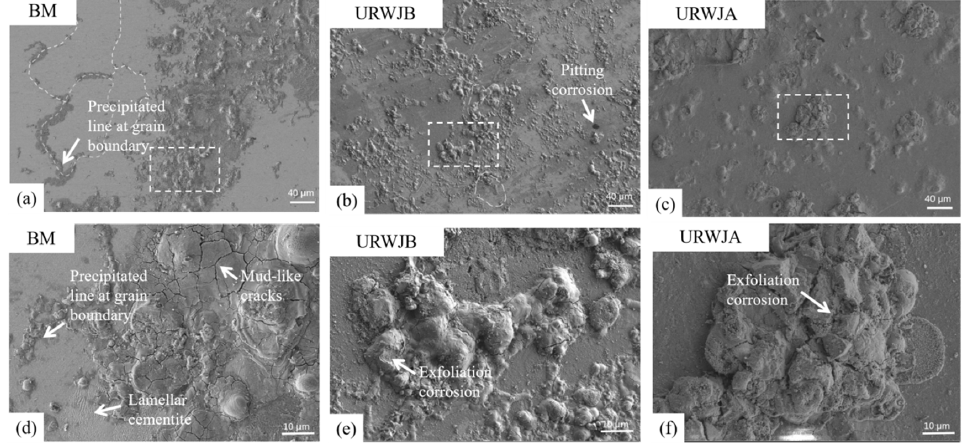
Figure 9. Morphology of samples after electrochemical test: BM, URWJB, URWJB. Without normalisation, all the microzone surfaces of the URWJs were severely cor ‐ roded after cyclic potentiodynamic polarisation, showing major non ‐ uniform surface ex ‐ foliation and a large number of dispersive corrosion products (Figure 9b,e). After normal ‐ isation, the corrosion products were more densely distributed on the sample surface com ‐ pared to the URWJB samples (Figure 9c,f). Thus, it is reasonable to conclude that the UR